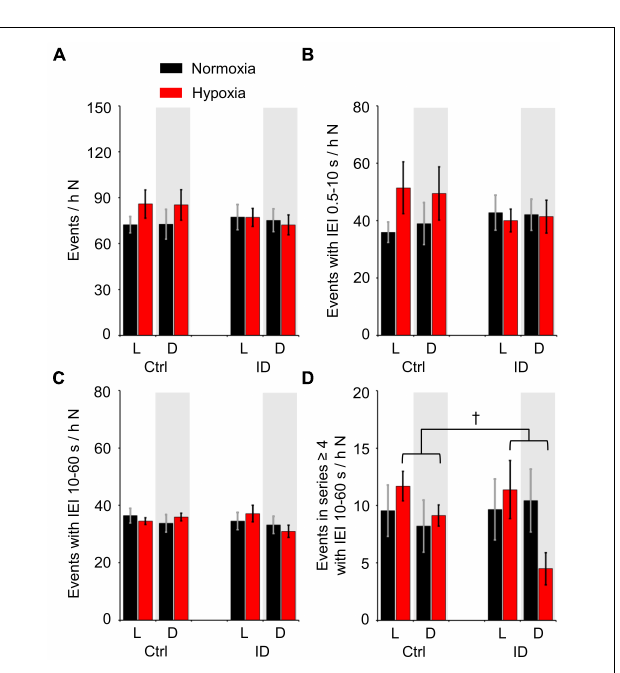
FIGURE 4 | Distribution of the time intervals (inter-event intervals, IEI) between consecutive tibialis anterior (TA) electromyographic (EMG) events, expressed as number of IEI per hour of time spent in non-rapid-eye-movement sleep (N), in mice fed control diet (Ctrl, A,B ) or iron-deficient diet (ID, C,D ) during normoxia (black) and hypoxia (red). Data are shown separately for the light period (A,C) and dark period (gray shading, B,D ) as means ± SEM with n = 8 per group. ANOVA did not indicate any significant effects of the light/dark period, hypoxia/normoxia, and Ctrl/ID group (cf. text for details).